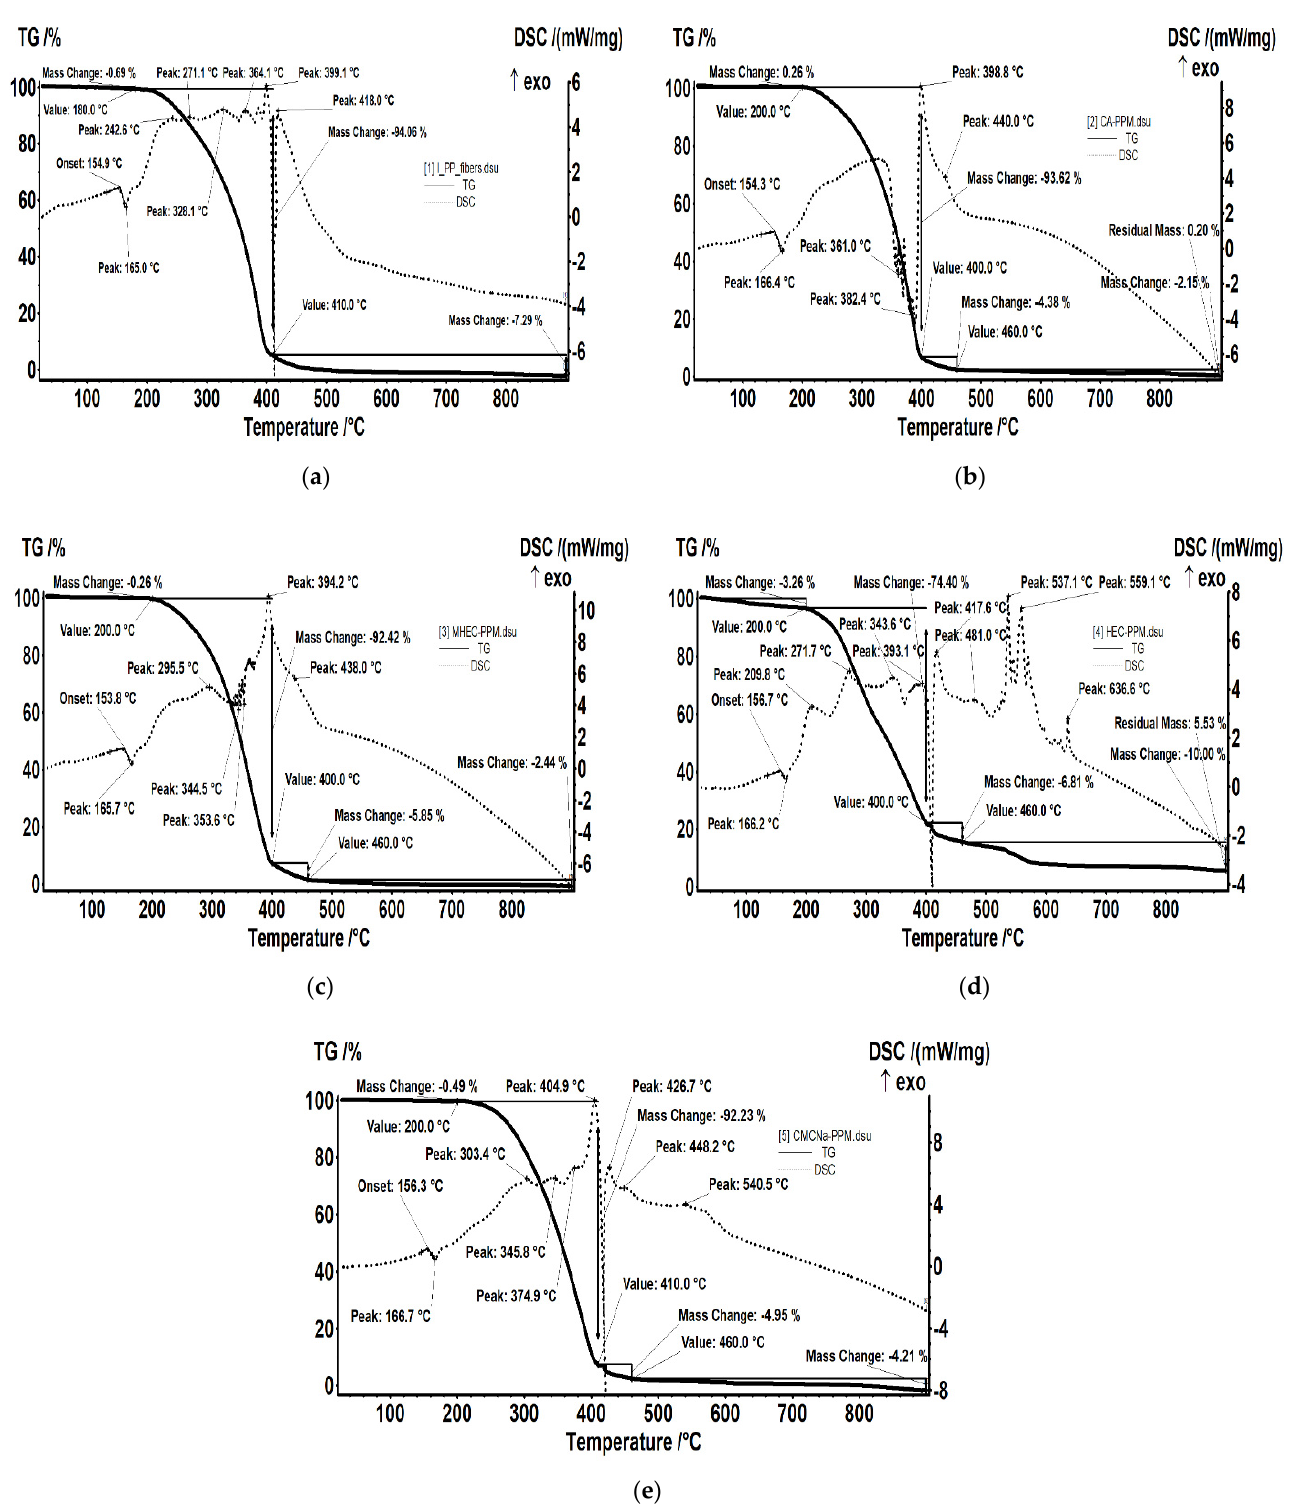
Figure 6. Thermal diagrams for hollow fiber membranes: ( a ) PPM; ( b ) CA–PPM; ( c ) MHEC–PPM; ( d ) HEC–PPM; ( e ) NaCMC–PPM.